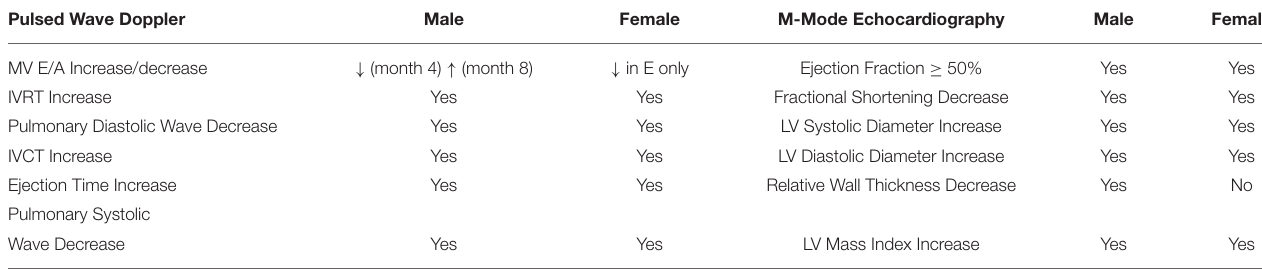
TABLE 2 | Cardiac function and morphology on echocardiography in diabetic rats. Pulsed Wave Doppler Male Female M-Mode Echocardiography Male Female